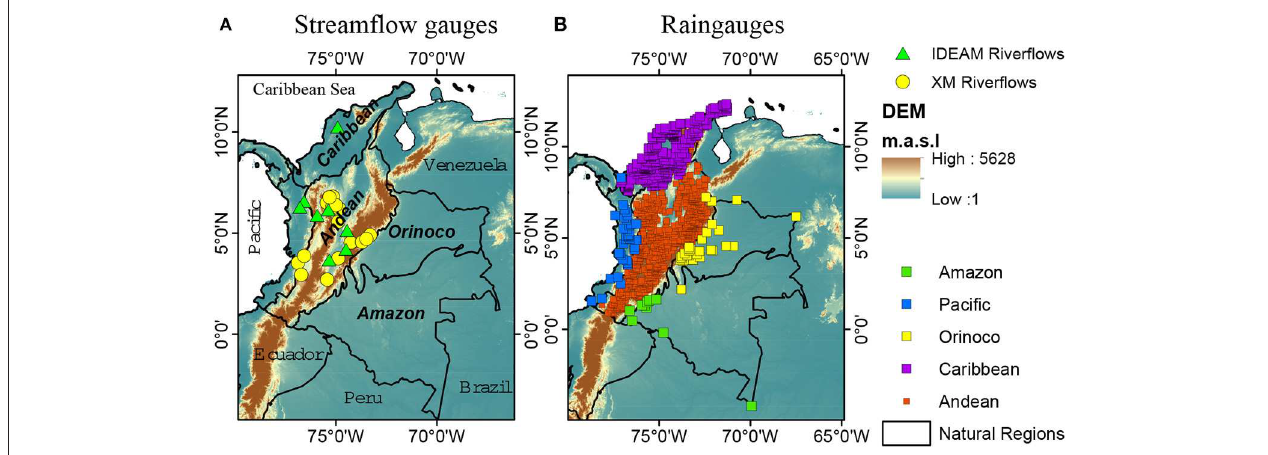
FIGURE 3 | National context including the Colombian Natural Regions as well as the streamflows and rainfall gauges. (A) Streamflow gauges. (B) Raingauges.